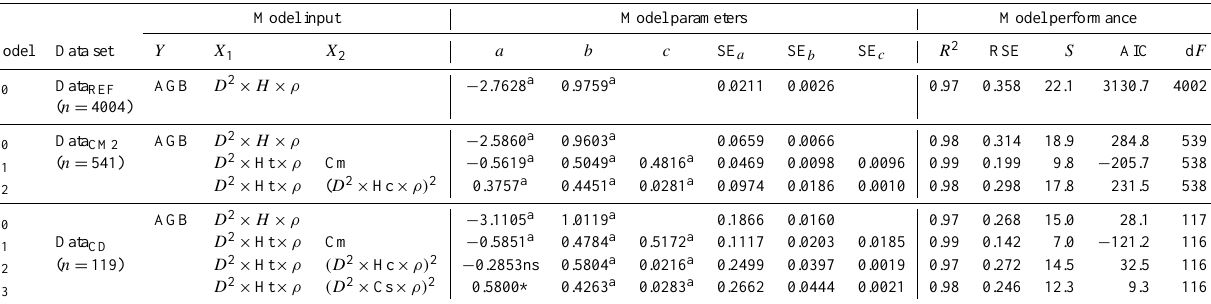
Table 2. Models used to estimate tree AGB. Model parameters are D (diameter at breast height,cm), H (total height, m), Ht (trunk height, m), Hc (crown depth, m), Cm (crown mass, kg), Cs (average of Hc and crown diameter, m) and ρ (wood density, gcm − 3 ) . The general form of the models is ln( Y) = a + b × ln (X 1 ) + c × ln (X 2 ) . Model coefficient estimates are provided along with the associated standard error is denoted by SE i , with i as the